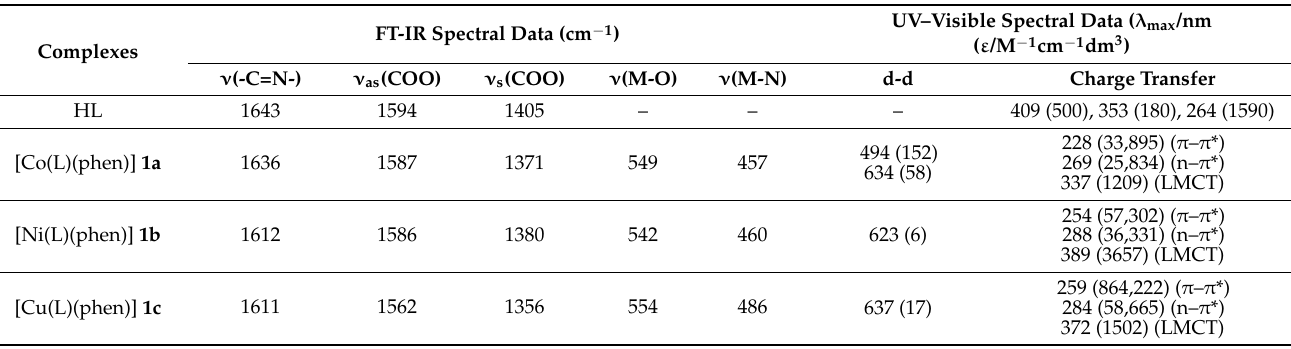
Table 2. FT-IR and UV–visible spectral data of mixed ligand metal(II) complexes 1 ( a – h ).